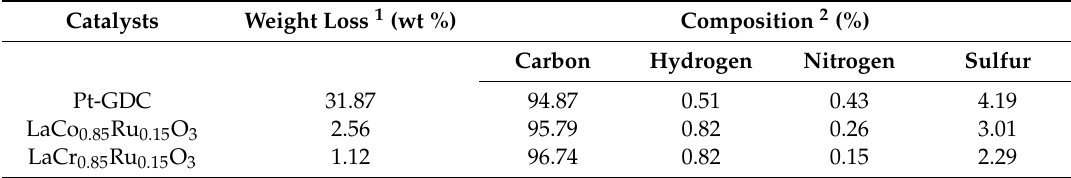
Table 4. Weight loss and compositions of C, H, N, S of the used LaCr 0.85 Ru 0.15 O 3 , LaCo 0.85 Ru 0.15 O 3 and Pt-GDC catalysts after LCO-ATR for 25 h.